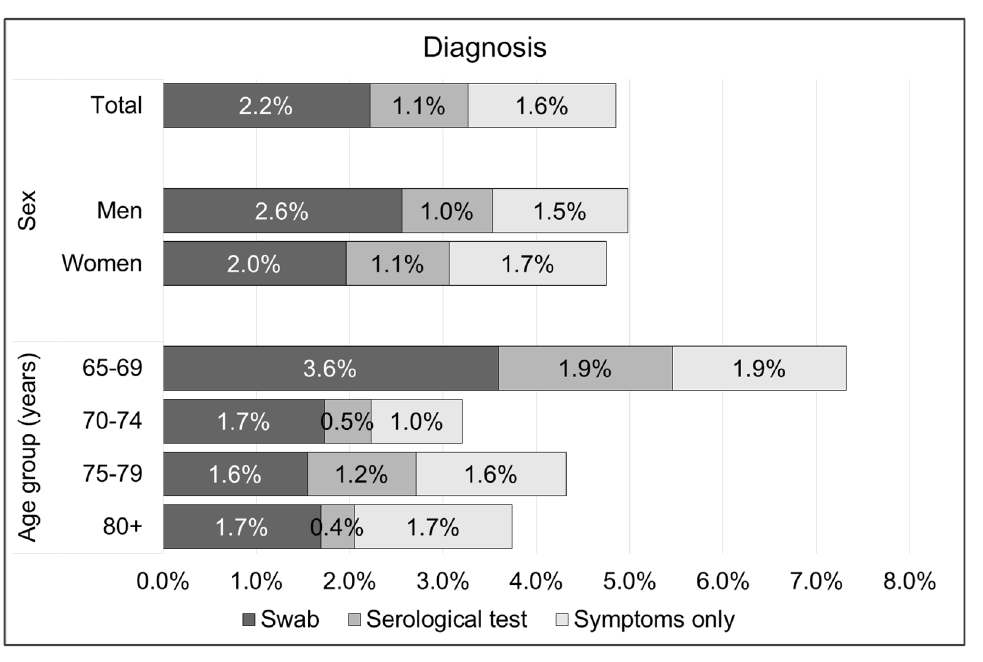
Figure 1. Distribution of 4.400 Italian subjects aged 65 years or above according to COVID–19 infec- tion and type of diagnosis, overall and by sex and age group. Lombardy region, Italy, 2020.